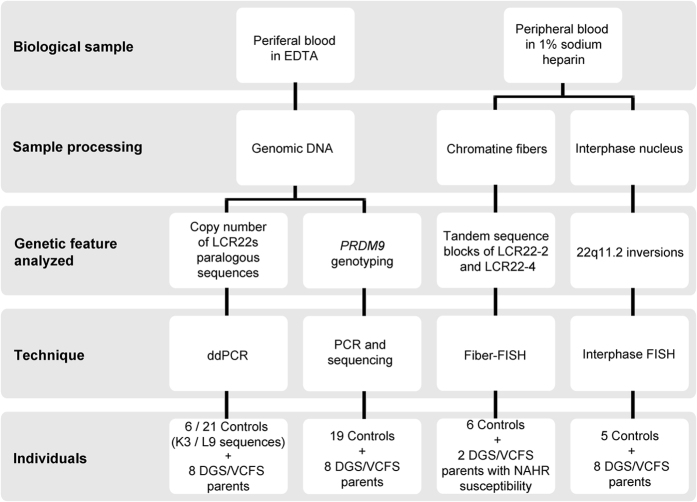
Experimental design.